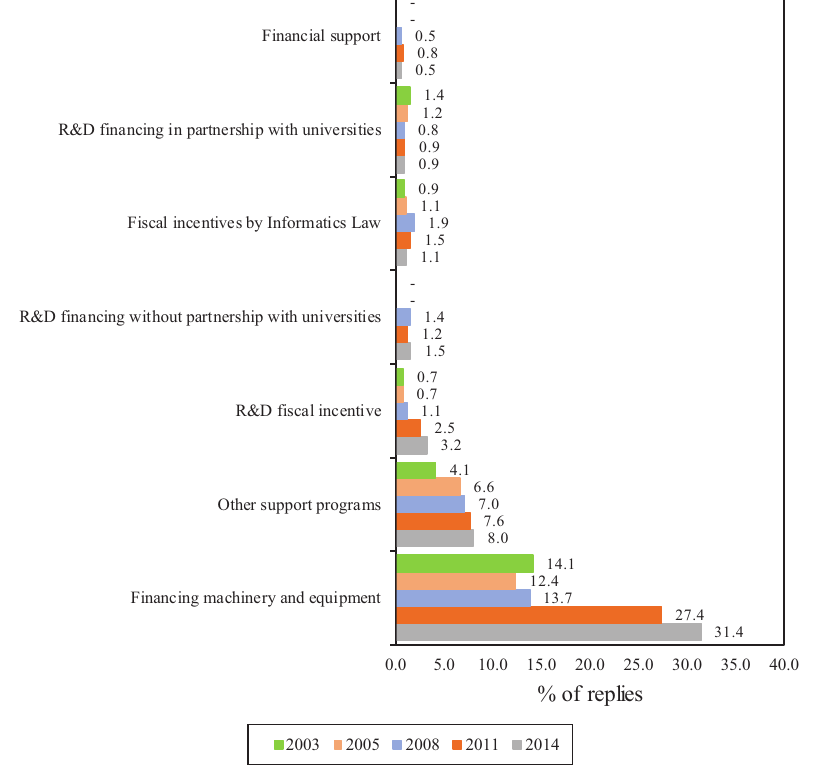
Figure 6. Percentage